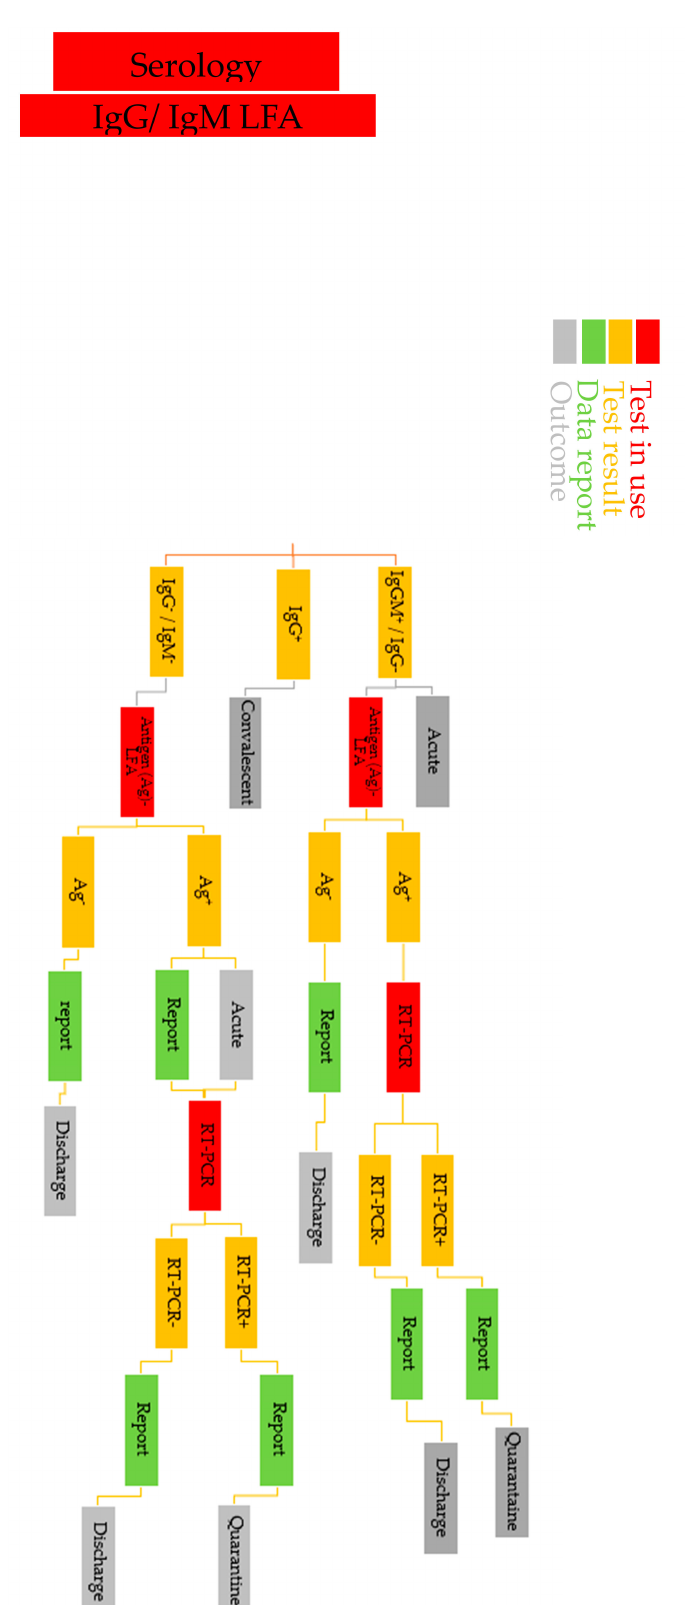
Figure 2. Testing algorithm schema applied for screening the population involved the current